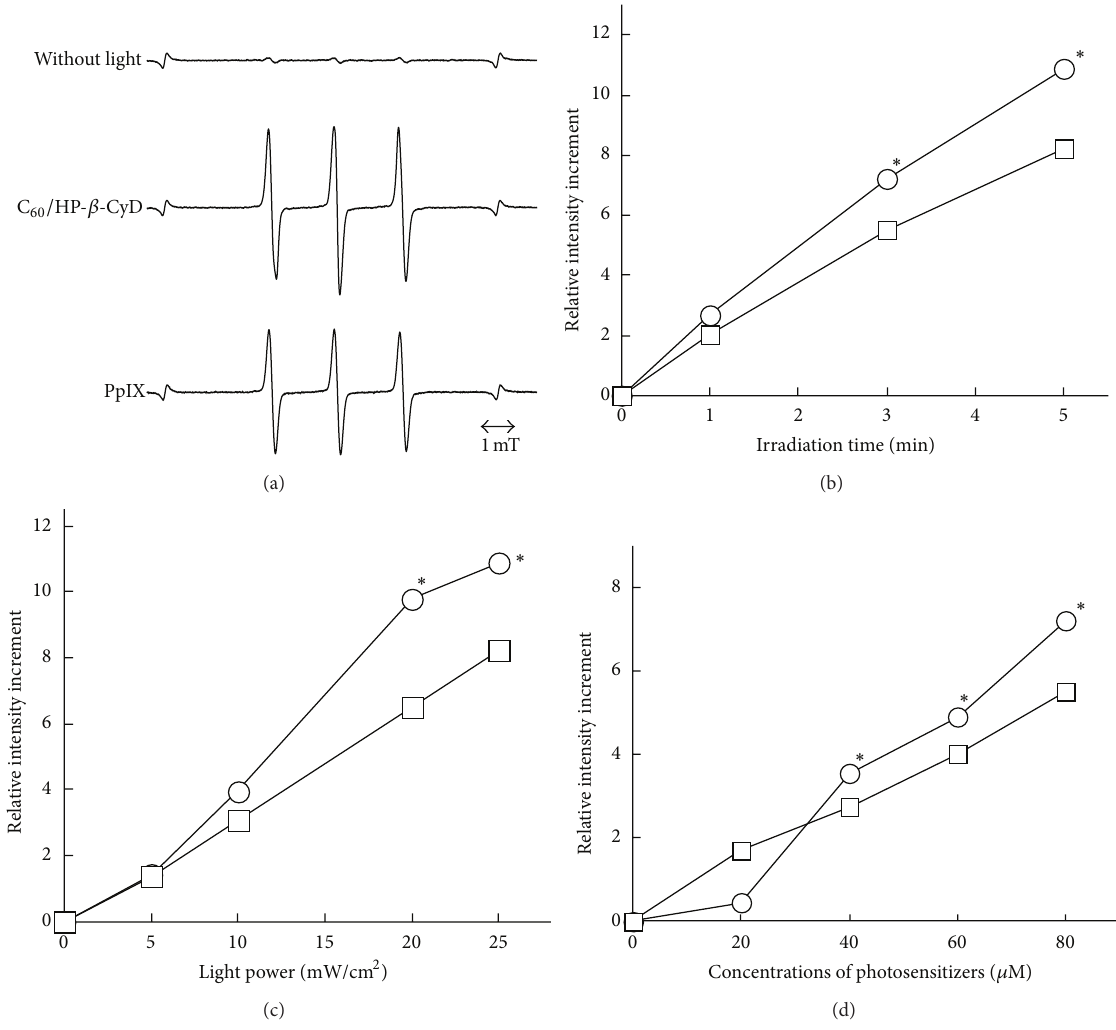
Figure 1: ESR spectra of the TEMPO-OH adduct generated in a C 60 /HP- 𝛽 -CyD colloidal solution and a PpIX solution (C 60 and PpIX = 80 𝜇 M, light irradiation at 25 mW/cm 2 for 5 min) (a). Its relative intensity increment after visible light irradiation. (b) Effects of the light power (c) and concentrations of photosensitizers (d) on the generation of 1 O 2 . Empty circle: C 60 /HP- 𝛽 -CyD nanoparticles; empty square: PpIX. Each point represents the mean ± S.E. of 3 experiments. ∗ 𝑃 < 0.05 versus